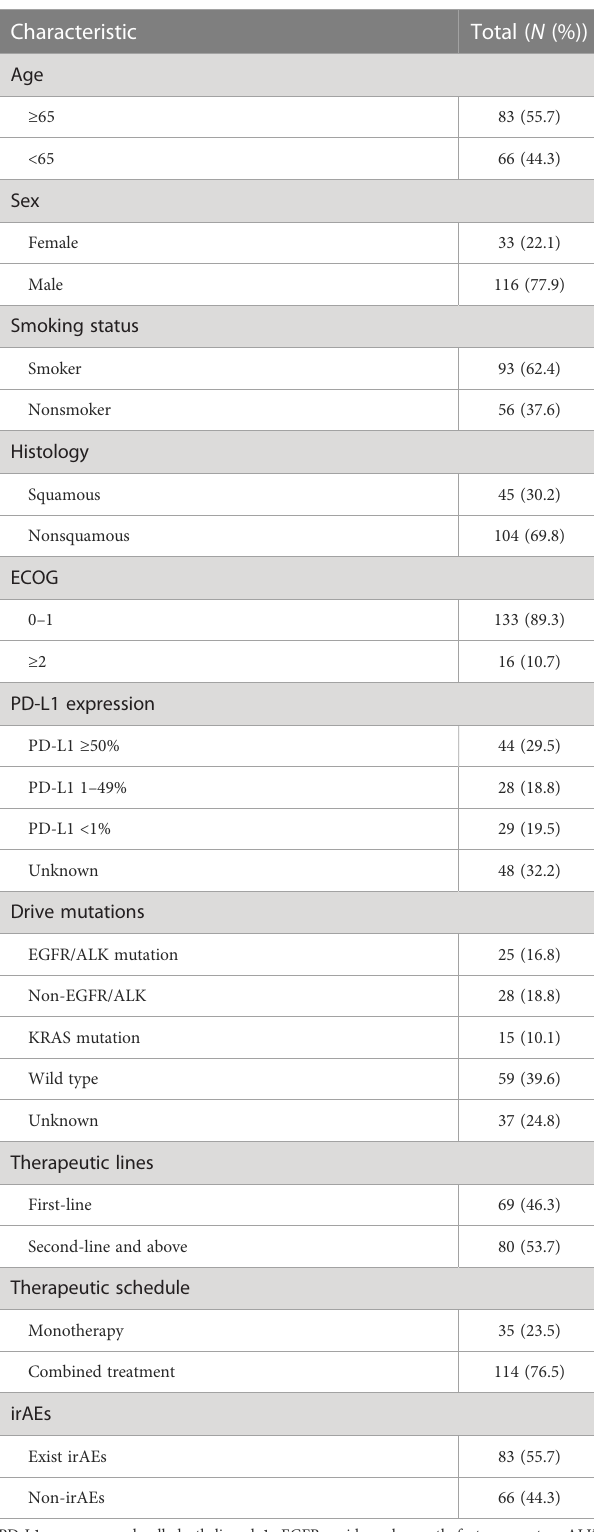
TABLE 1 Baseline characteristics of a cohort of 149 patients with